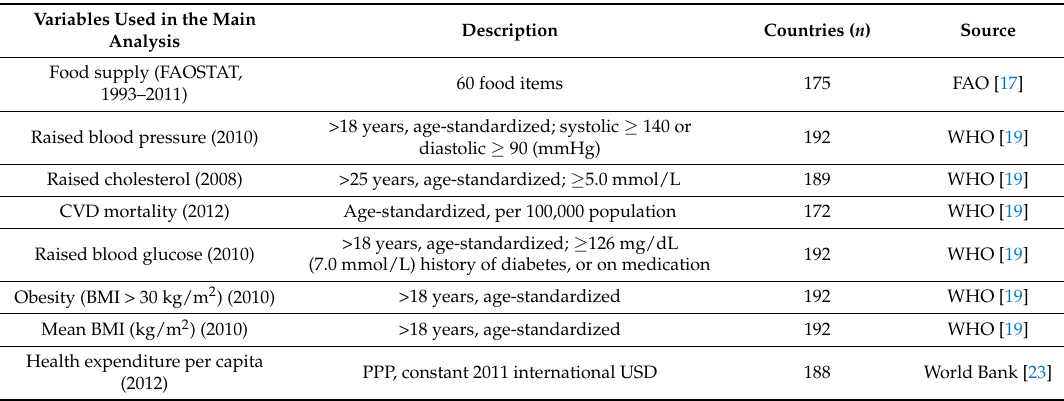
Table 1. Variables used in this